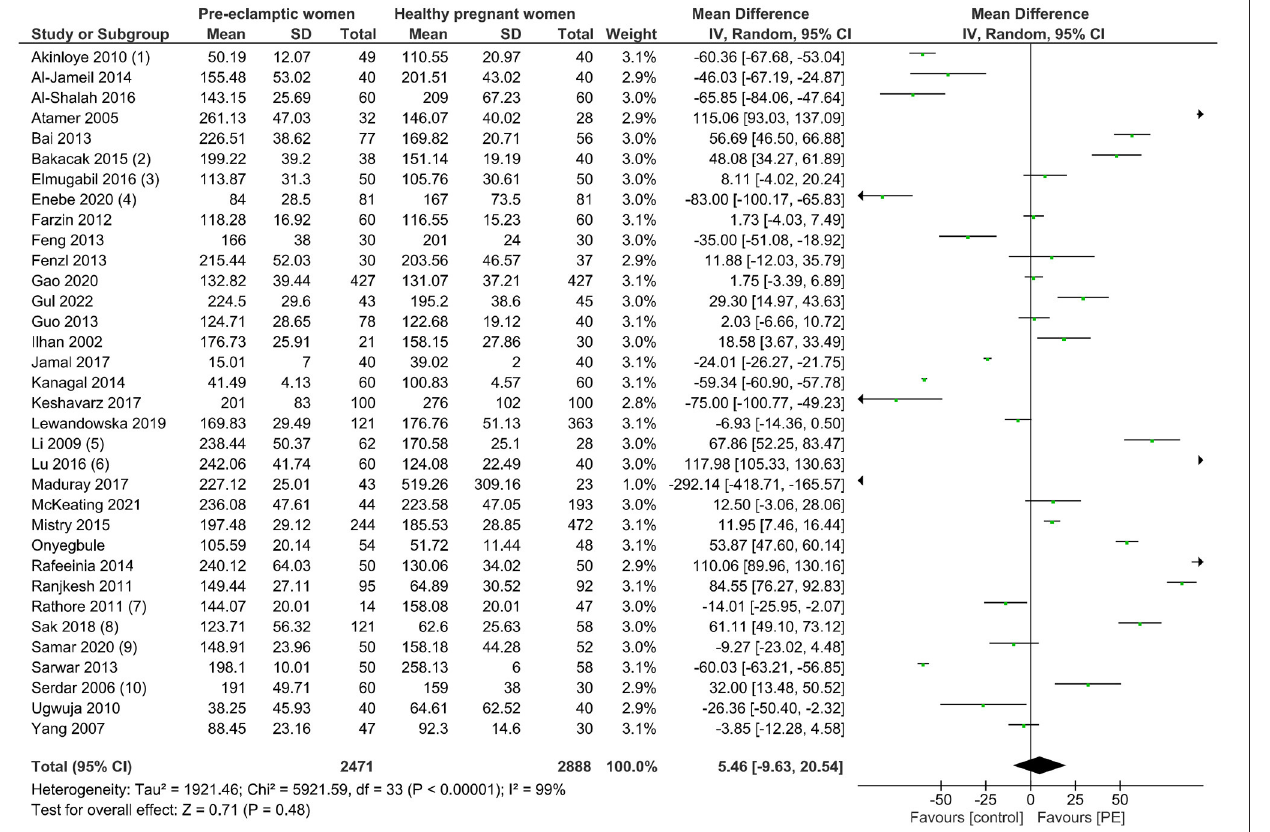
FIGURE 2 | The forest plot of the association between maternal copper levels and PE risk in included